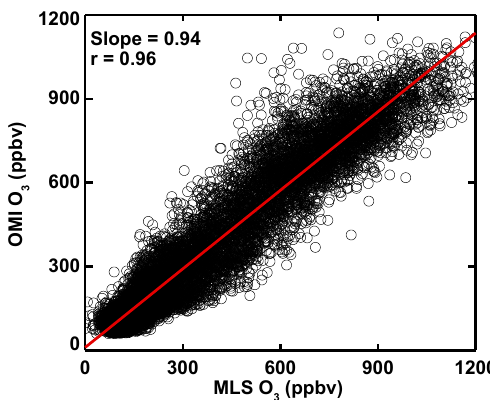
Figure 12. Same as Fig. 3 but for the OMI layer 18 O 3 mixing ratio versus the MLS O 3 mixing ratio at 100hPa for JJA 2008. The red line shows a linear fit. Correlation and slope for the linear fit are given in the upper left corner of the